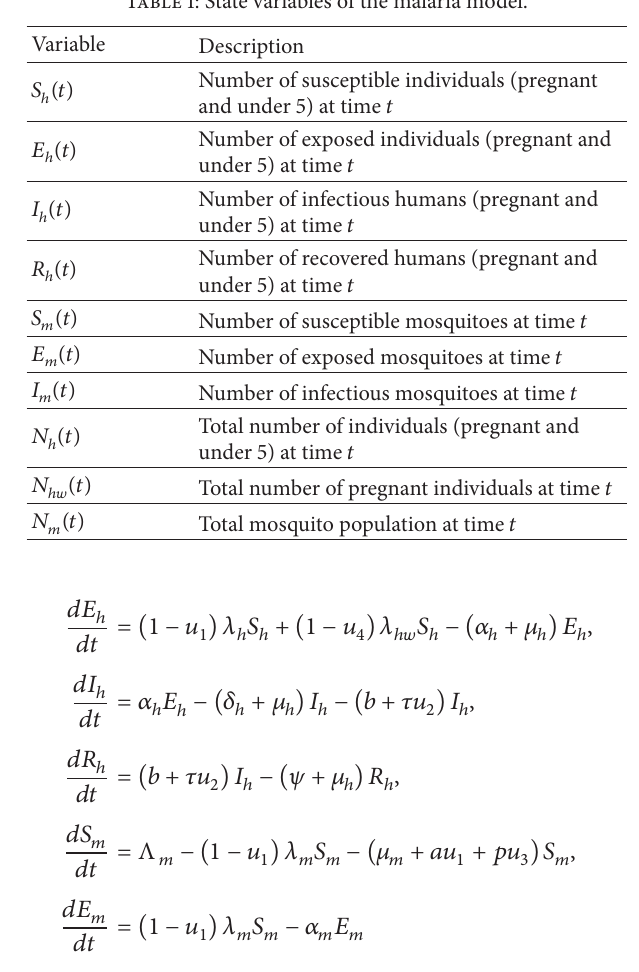
Table 1: State variables of the malaria